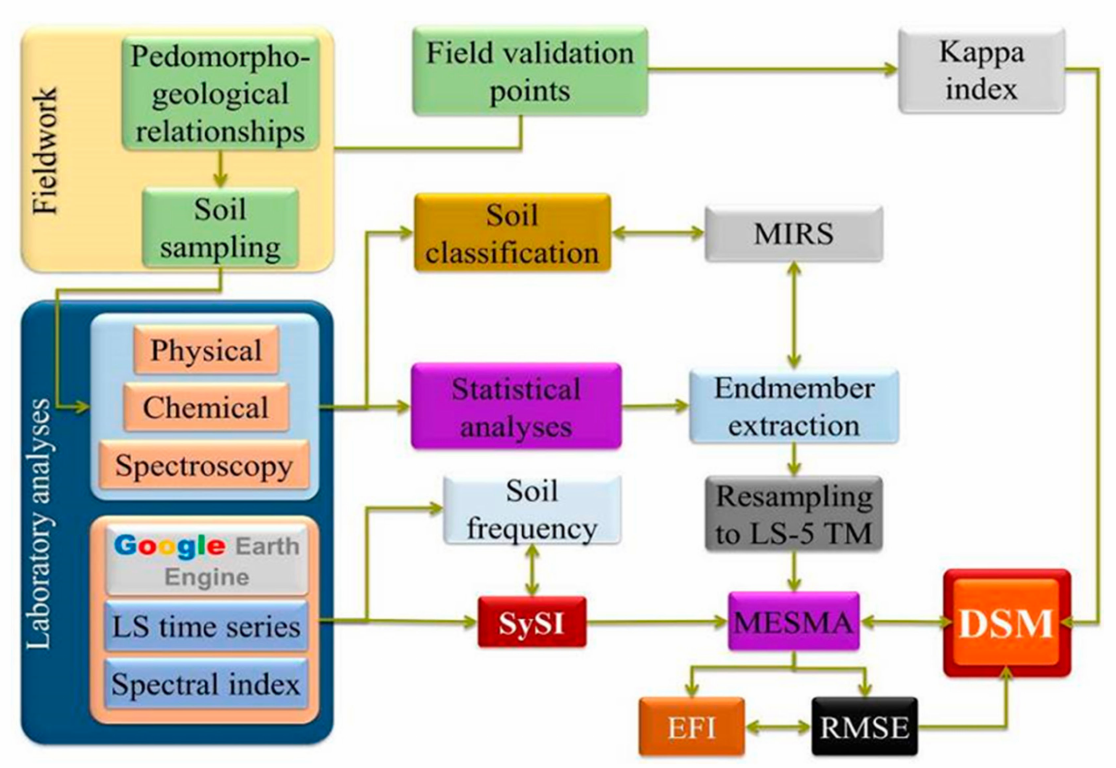
Figure 2. Flowchart of the methodology for the production of the digital soil map of the study area. MIRS: morphological interpretation of reflectance spectra [16]; LS: Landsat; LS-5 TM: Landsat 5 Thematic Mapper; DSM: digital soil map; EFI: endmember fraction image; RMSE: root mean square error; MIRS: morphological interpretation of reflectance spectra; and SySI: synthetic soil/rock